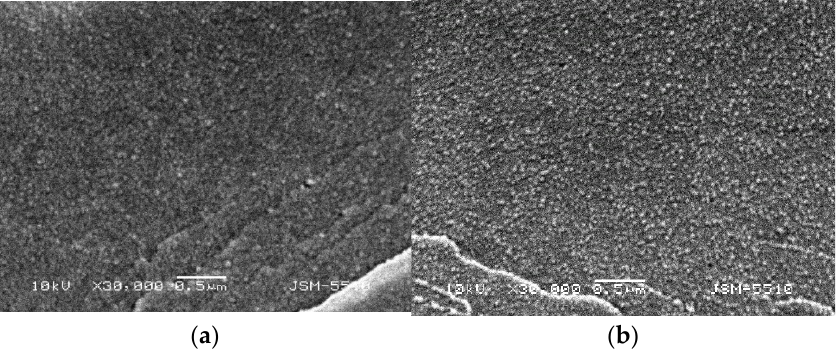
Figure 4. SEM micrograph of ( a ) IPN1 ( φ PDMAEMA = 0.26) and ( b ) IPN 4 ( φ PDMAEMA = 0.52) at magnification ×30,000.